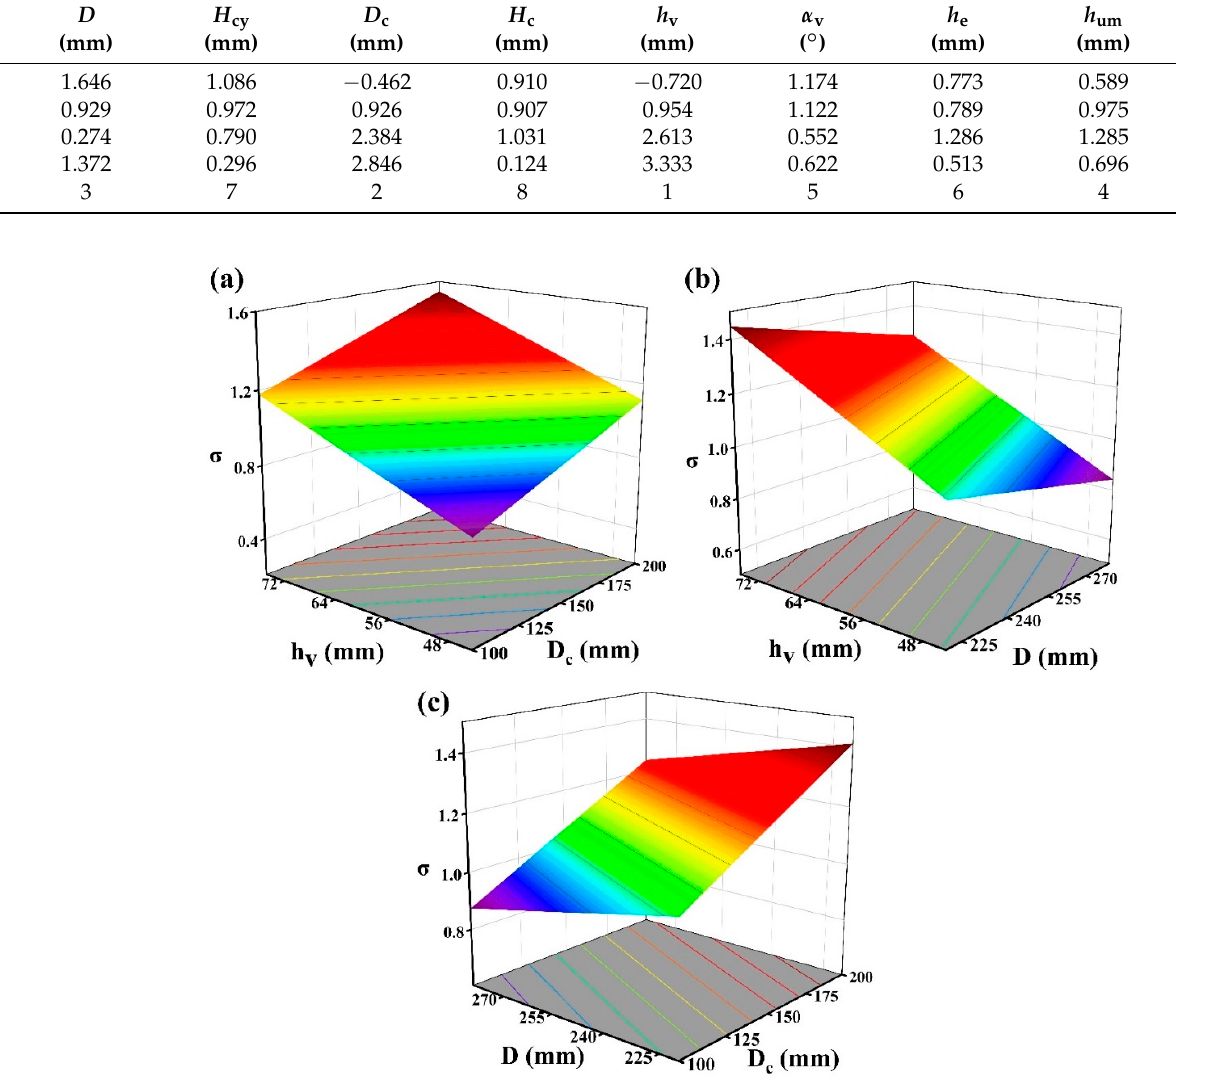
Figure 9. The influence of guide vane height ( h v ), cone section diameter ( D c ), and cylinder section diameter ( D ) on σ .